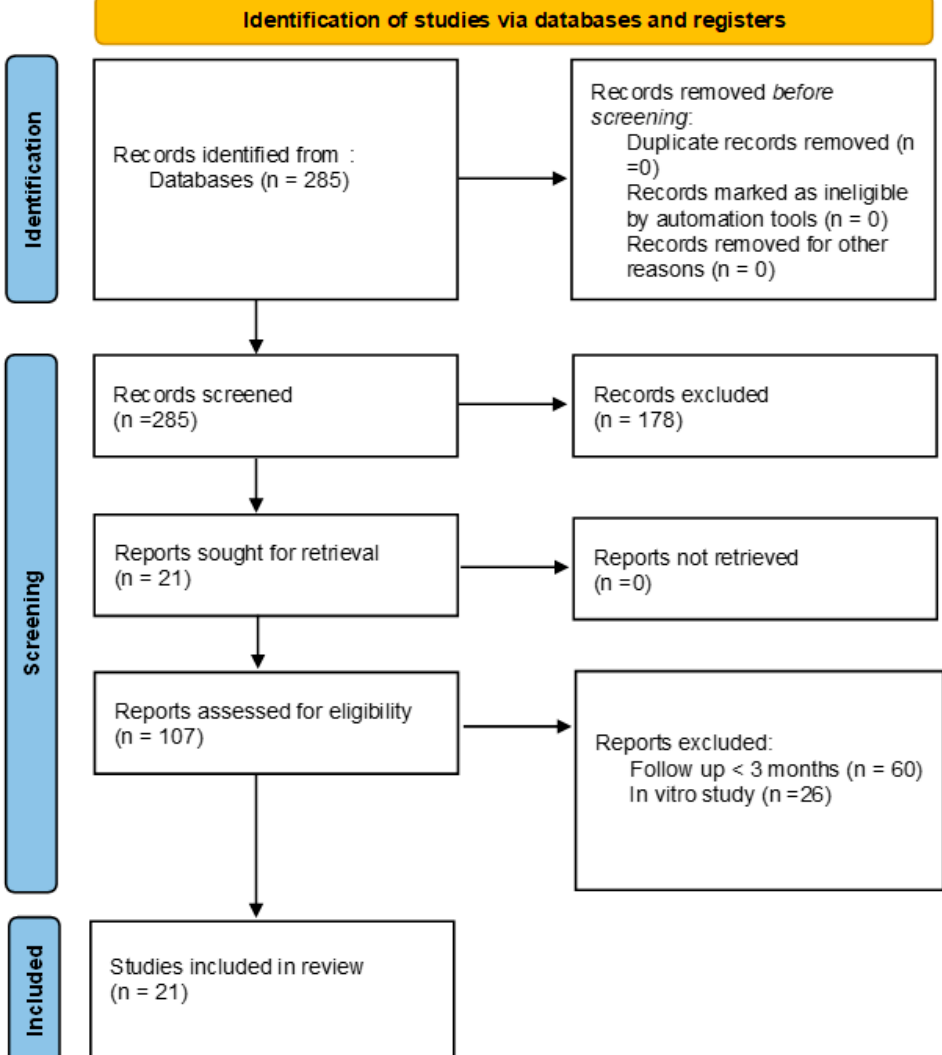
Figure 1. Study selection process and literature search results (PRISMA flowchart).